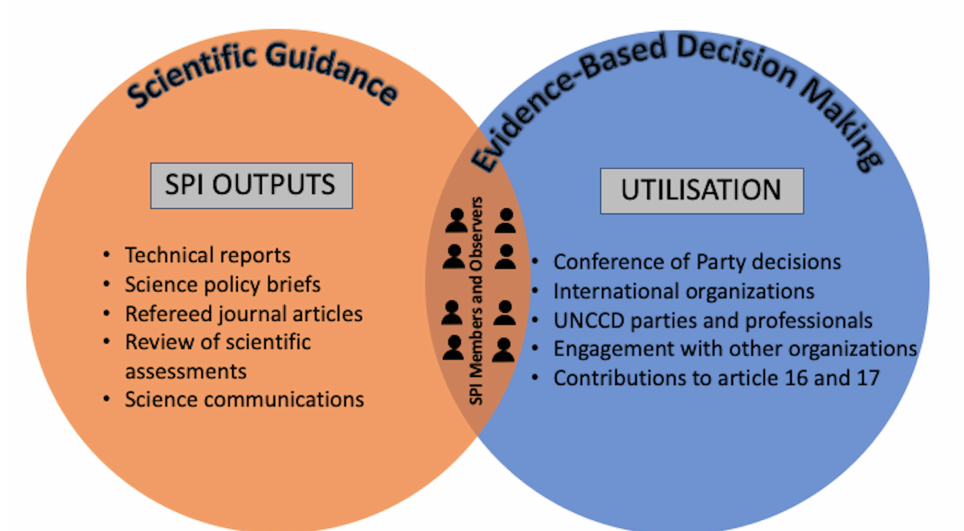
Figure 1. Framework to analyze SPI outputs and subsequent utilization by decision makers within the UNCCD context. The framework for assessing the utilization of SPI outputs was adapted to the assessment dimensions and quality indicators outlined in the Framework for the Quality Assessment of Social Science Research